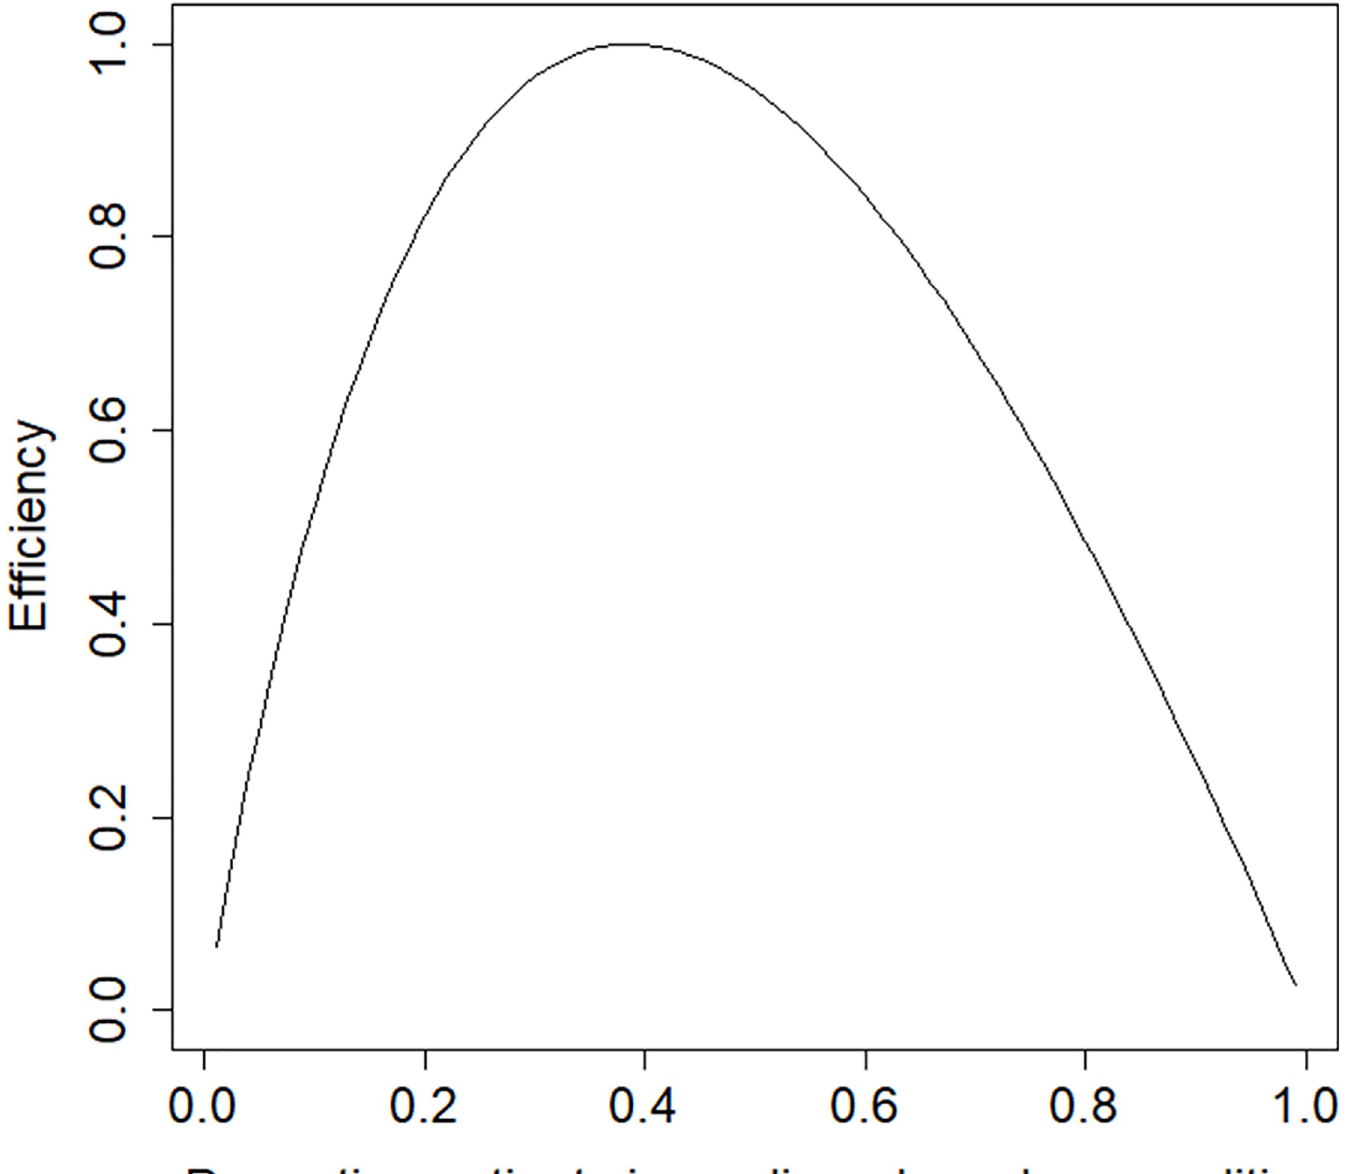
Fig 6. Efficiency graph for the trauma